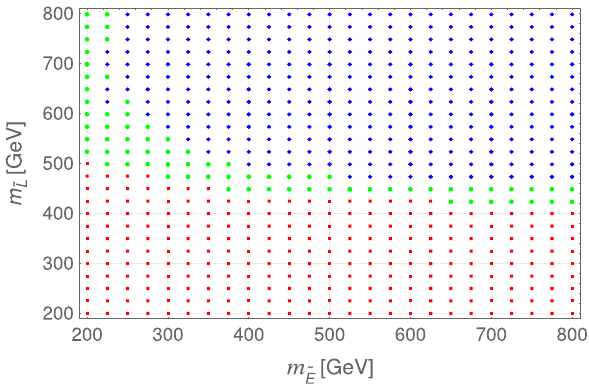
Fig. 4 Constraints on combinations of m ˜ ton/sneutrino production in the case of a higgsino LSP with M 1 = M 2 = 1 TeV, μ = 120 GeV and tan β = 10. Red points are excluded, blue ones are allowed and in the case of the green ones no conclusive statement can be made, within the known theoretical and experimental